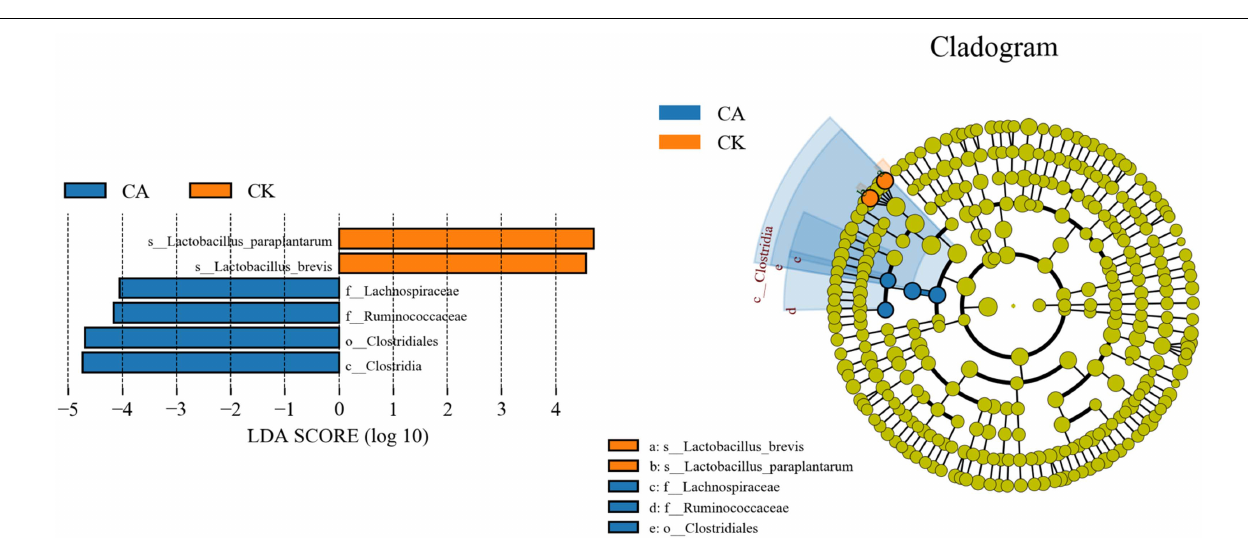
FIGURE 4 | Comparison of microbial variations using the LEfSe online tool for KG silage (CK, control; CA, Citric